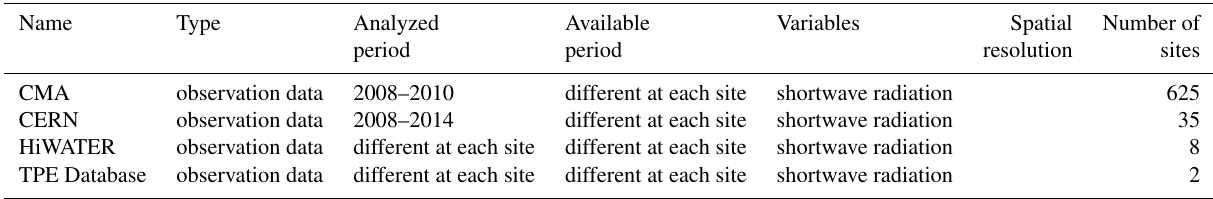
Table 2. Basic information for shortwave radiation observation data used to validate the forcing data sets. Name Type Analyzed Available Variables Spatial Number of period period resolution sites CMA